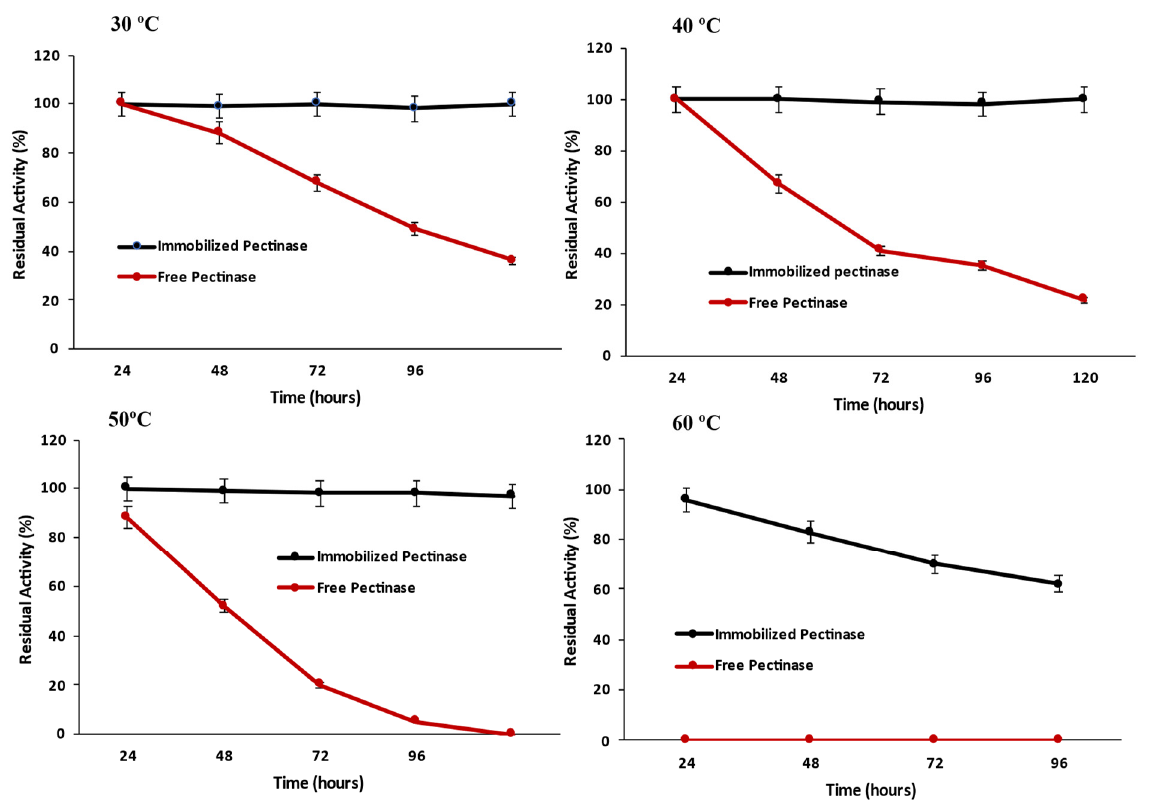
Figure 9. Thermal stability of pectinase immobilized magnetic iron oxide nanocarrier against different temperature.